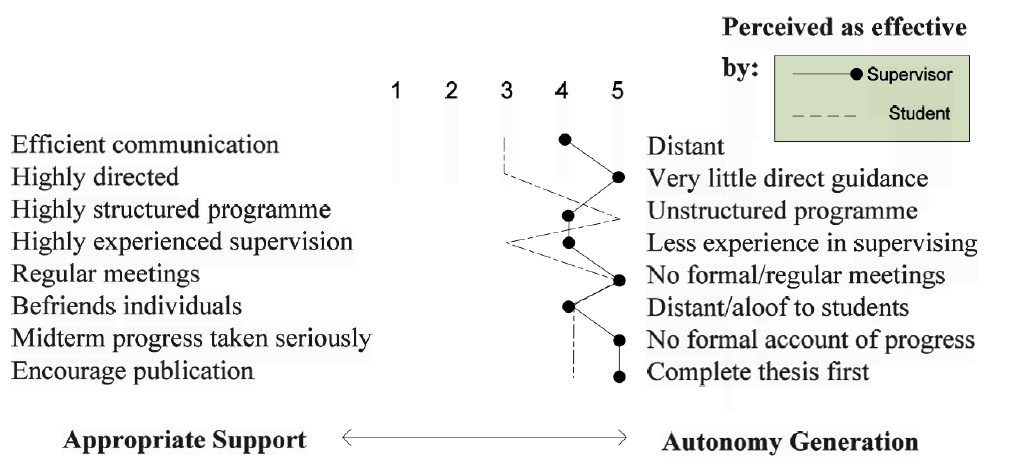
Figure 7 Rating towards completion